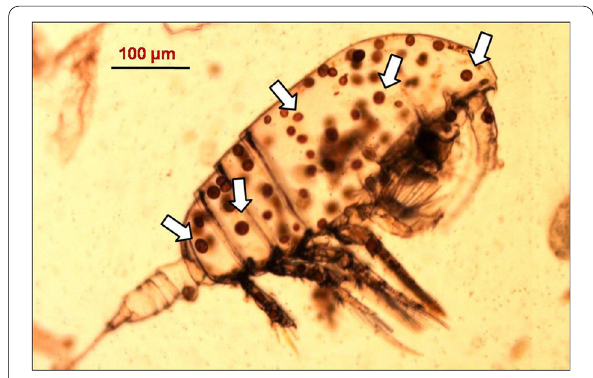
Fig. 2 Copepod Bestiolina similis infested with apostome ciliate Vampyrophrya pelagica LM (Scale bar: 100 μm)